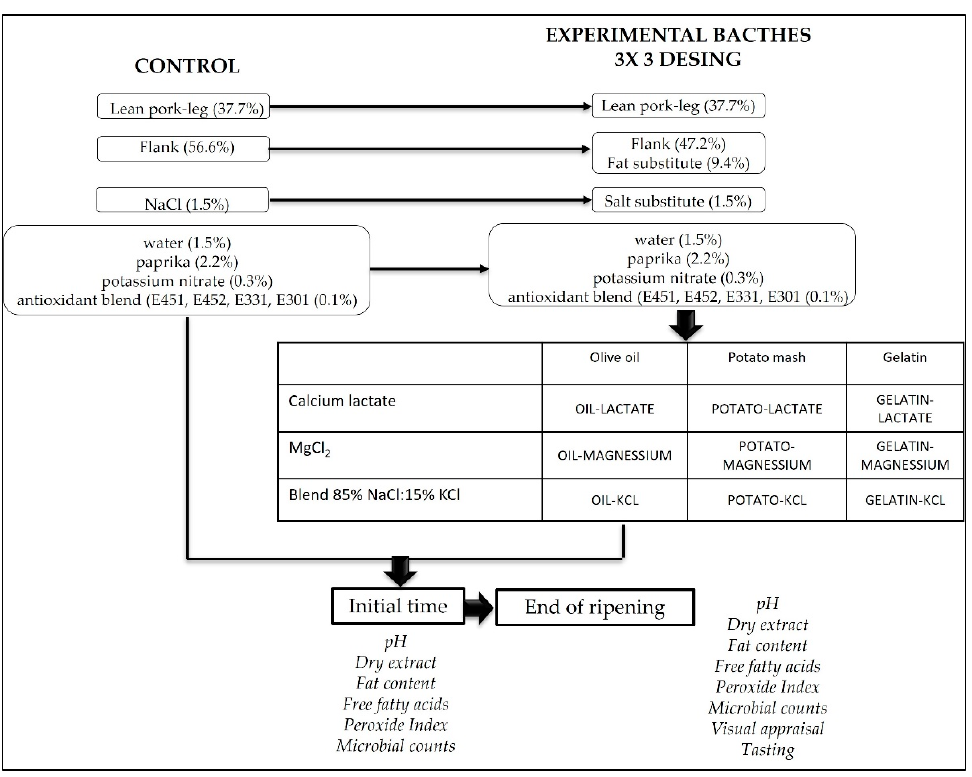
Figure 1. Experimental design.